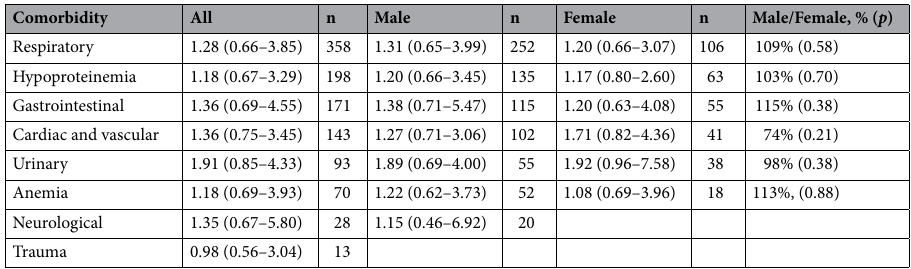
Table 2. Plasma NPC2 concentrations in sepsis patients of different genders and comorbidities. NPC2 concentrations are expressed in median (interquartile range, ng/ml). The Mann–Whitney U test was used to compare plasma NPC concentrations in male and female patients.